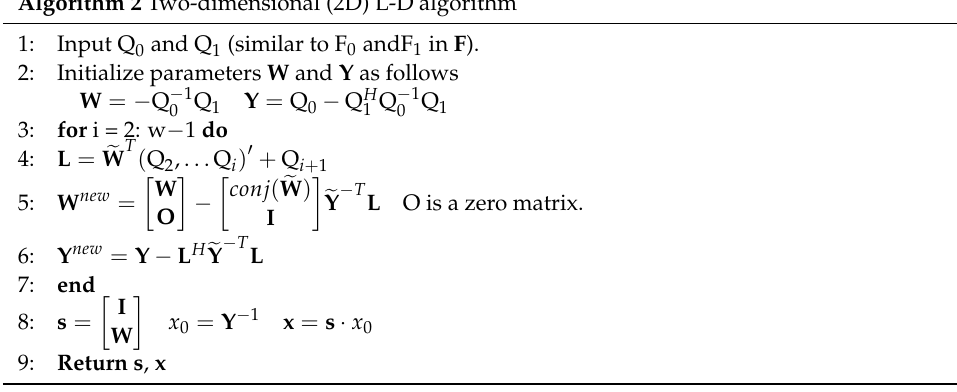
Algorithm 2 Two-dimensional (2D) L-D